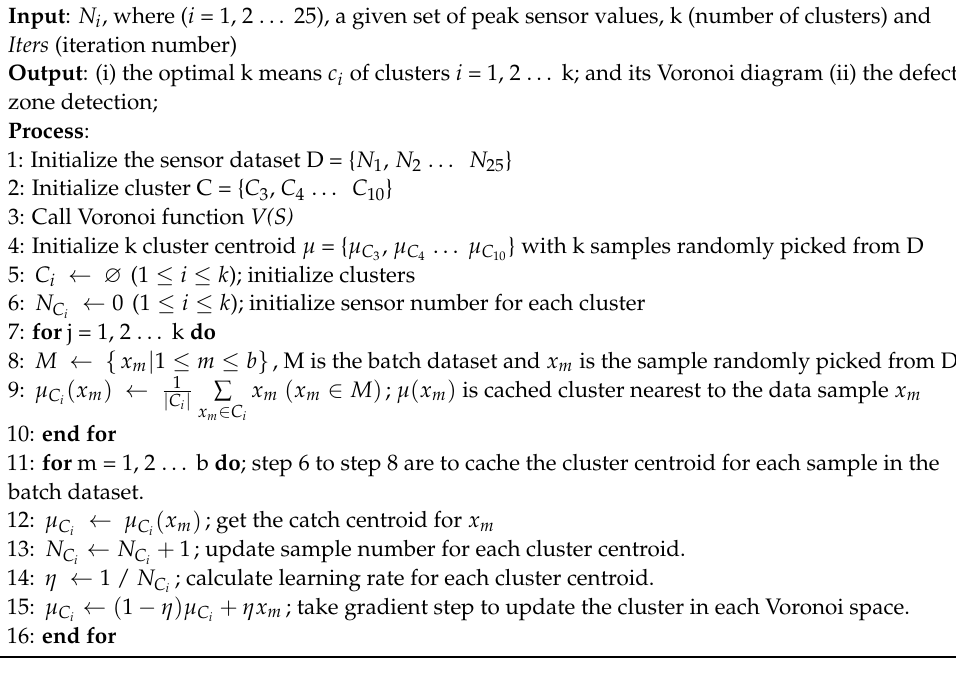
Algorithm 2 Sensor Defect Analysis Using Voronoi_k-Means (S,